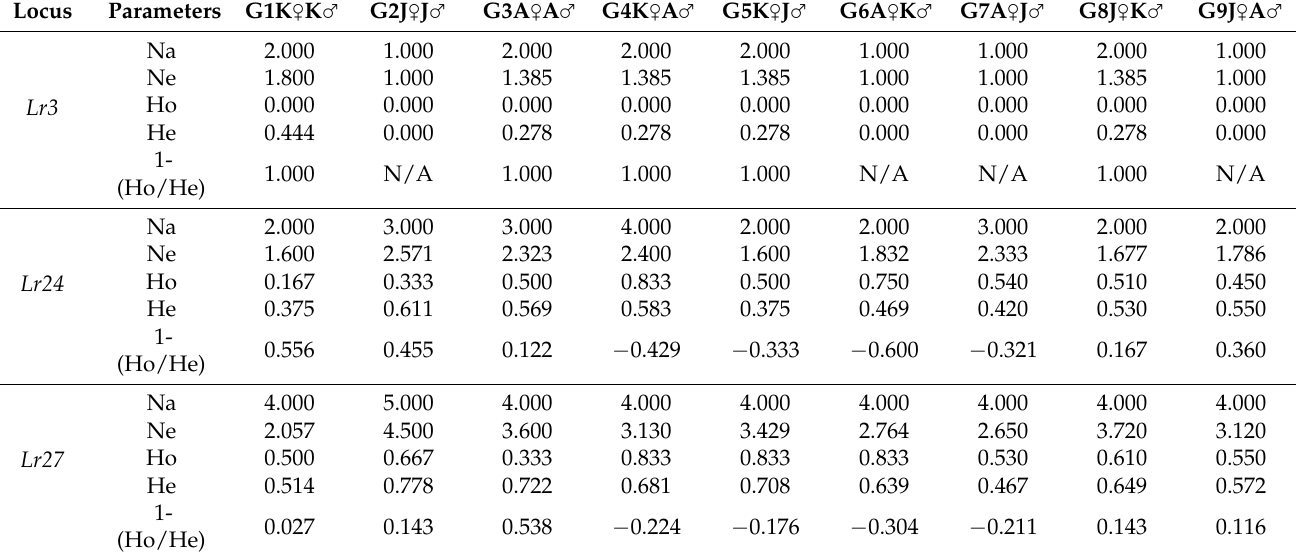
Table 6. Genetic variations at three microsatellite loci (Lr3, Lr24 and Lr27) in nine different groups of Ariza labeo ( L. ariza ). The single words picked to name the purebred and crossbred groups bear the full forms as G → Group, K → Kangsha River stock, J → Jamuna River stock and A → Atrai River stock. Locus Parameters G1K